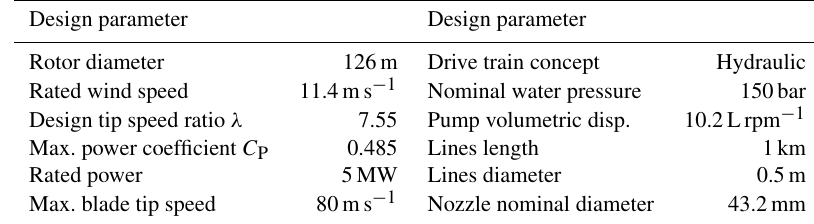
Table 2. Main design parameters for the offshore wind turbine with fluid power transmission.